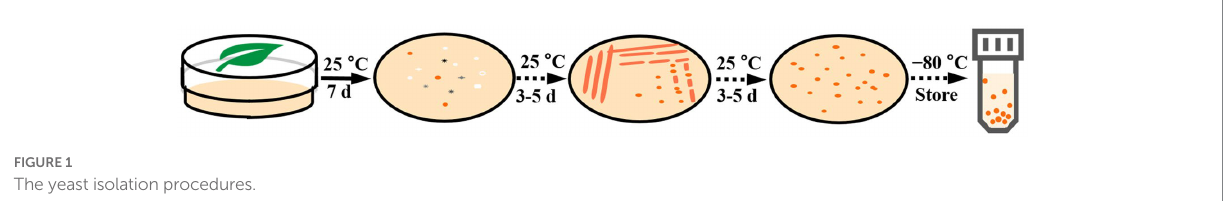
FIGURE 1 The yeast isolation procedures.